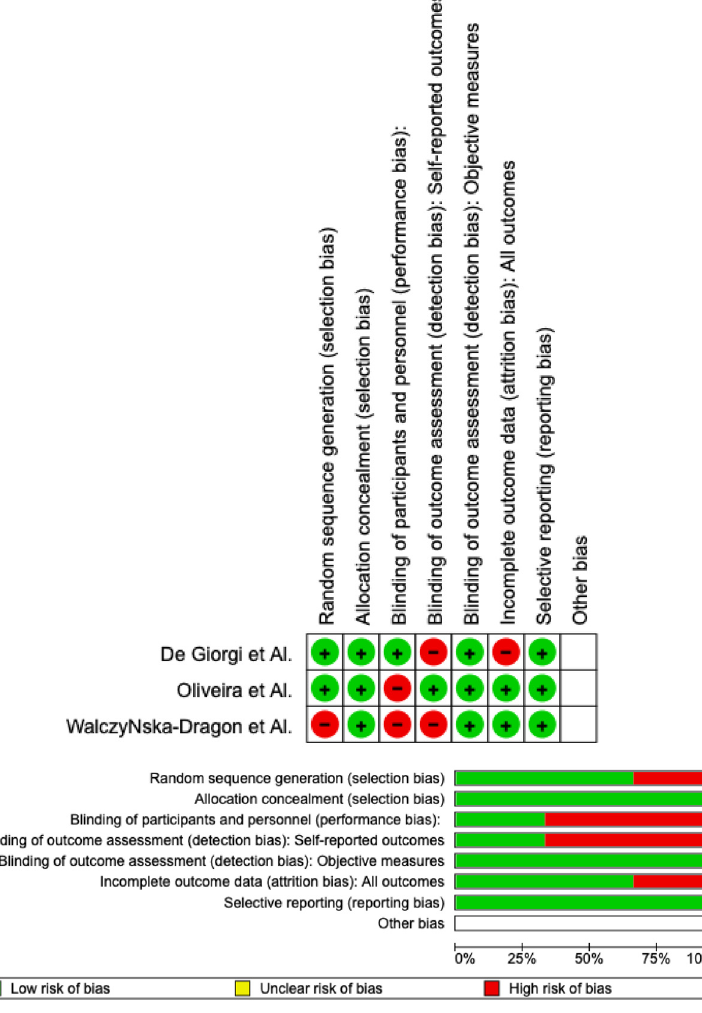
Figure 3. Risk of bias domains of the included studies [26–28].